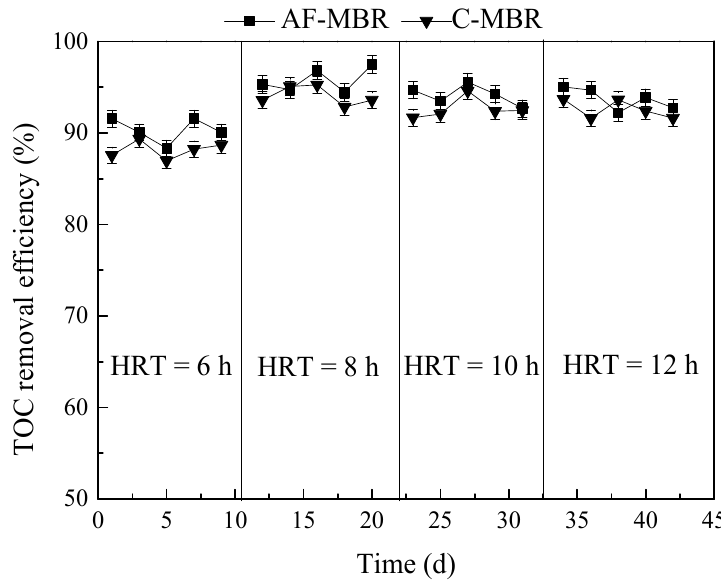
Figure 2. Influence of different HRTs on TOC removal efficiency.